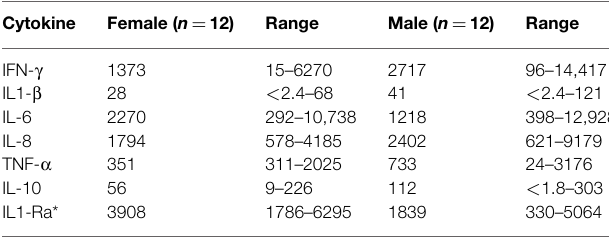
FIGURE 3 | Fetal testosterone levels, sex and gestational age . TABLE 3 | Medians and ranges of cytokine levels (pg/ml) in amniotic fluid of male and female infants